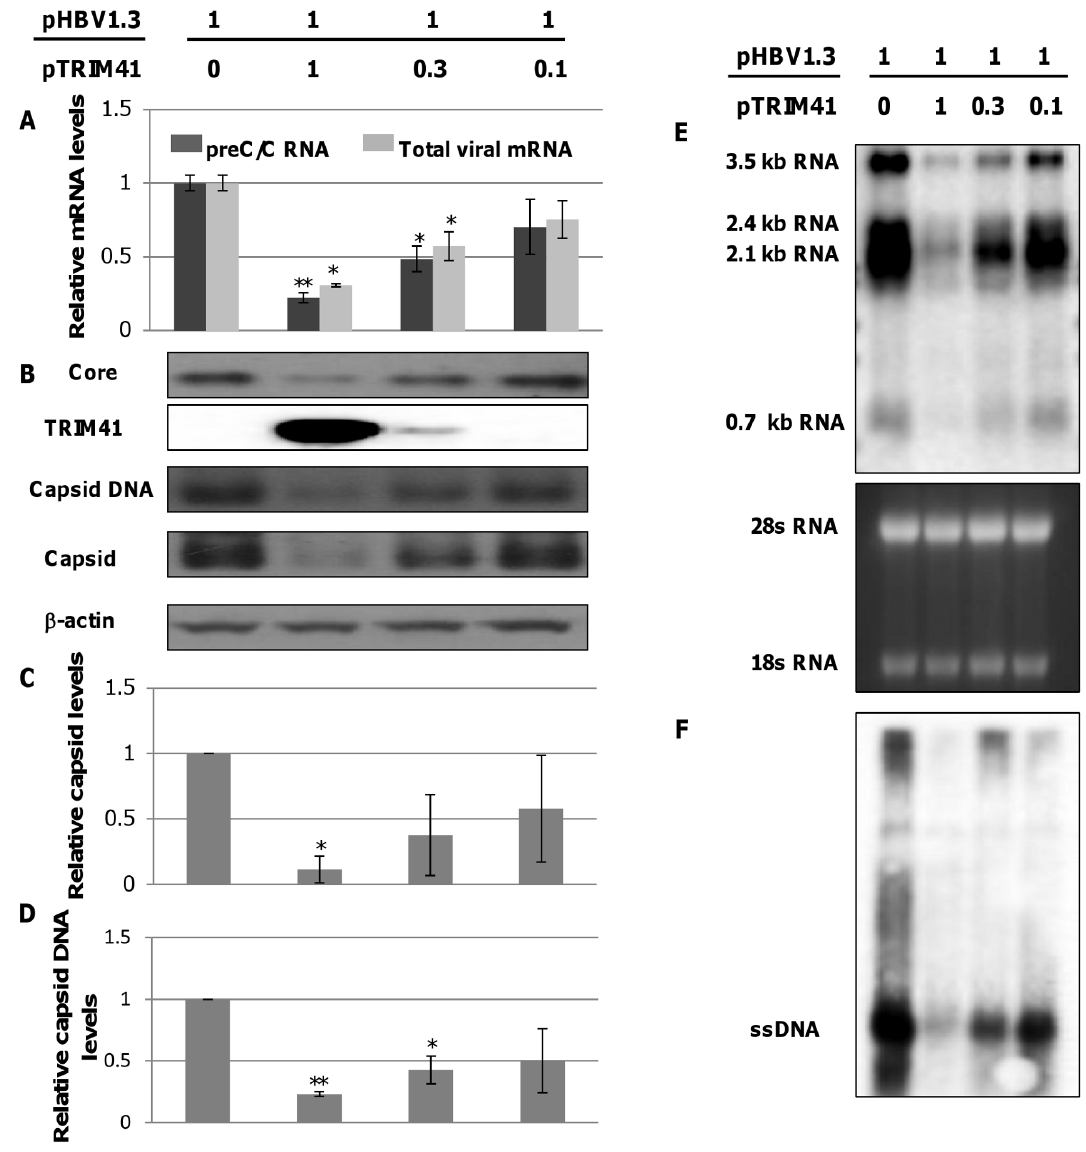
Figure 4. TRIM41 inhibits HBV replication by reducing the HBV mRNA levels. HepG2 cells in 12 well plates were co-transfected with 0.4 m g of pHBV1.3 and the indicated amounts of plasmid expressing TRIM41, supplemented with vector plasmid to make a total of 0.8 m g plasmid. (A) Cells were harvested at two days post transfection. The levels of HBV preC/C RNA and total mRNA were quantified by a real-time RT-PCR assay. (B) The amount of intracellular core protein was determined by a Western blot assay. The level of b -actin was used as a loading control. (C and D) The amounts of intracellular capsid (C) and capsid DNA (D) were determined by a viral particle gel assay. (E) HBV RNAs were determined by Northern blot hybridization. The positions of HBV preC/C RNA (3.5 kb), surface RNAs (sRNA; 2.4 kb and 2.1 kb) and HBx RNA (0.7 kb) are indicated. Ribosomal RNAs (28S and 18S) served as loading controls. (F) The cytoplasmic HBV capsid DNA was detected by Southern blot hybridization. The position of viral single strand DNA (ssDNA) is indicated. The mean and standard deviations were presented (n=3). * and ** indicate P , 0.05 and 0.01,